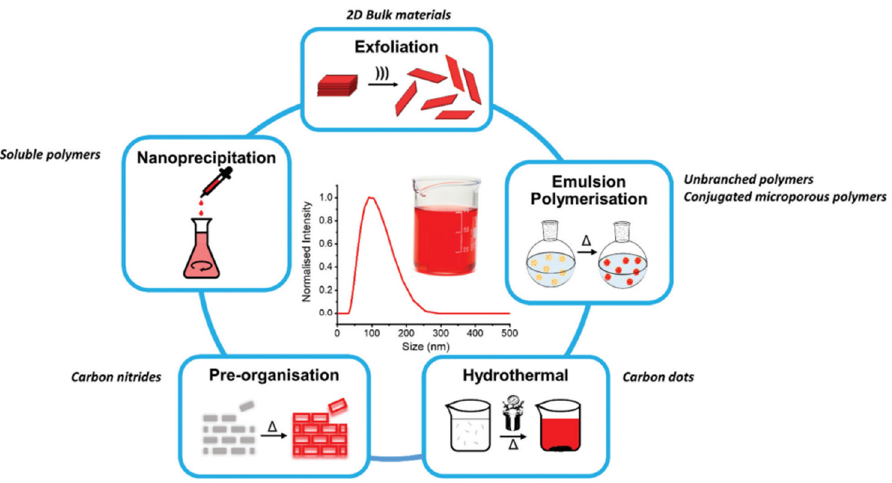
Figure 35. Illustration of the design strategies for conjugated polymer nanomaterials in the context of photocatalytic hydrogen production [Figure from ref. [23]].